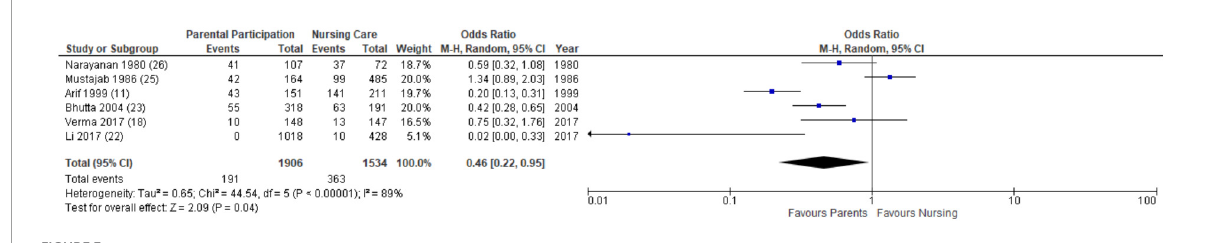
FIGURE3 Forest plot and meta-analysis of the association between parental participation and mortality.